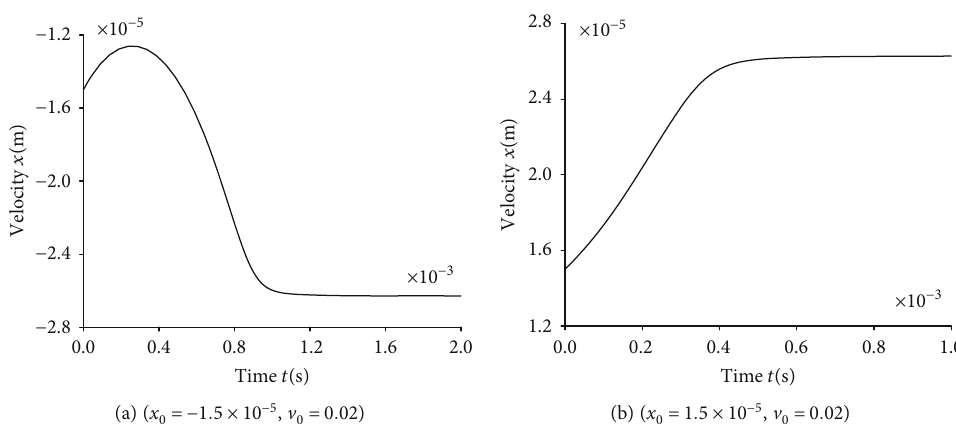
= 1 : 6A , q = 0 : 25 × 10 − 4 m 3 /s 0 0